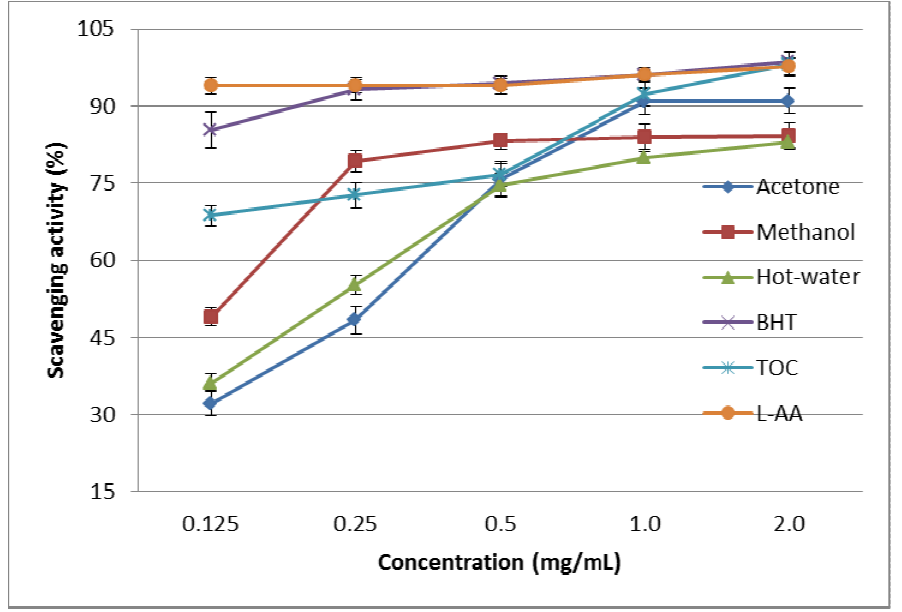
Figure 1. Scavenging activity of various extracts from the fruiting bodies of Pleurotus florida against 1,1-diphenyl-2-picrylhydrazyl. Values expressed as means ± SD ( n = 3). BHT, butylated hydroxytoluene; TOC, α -tocopherol; L-AA, L -ascorbic